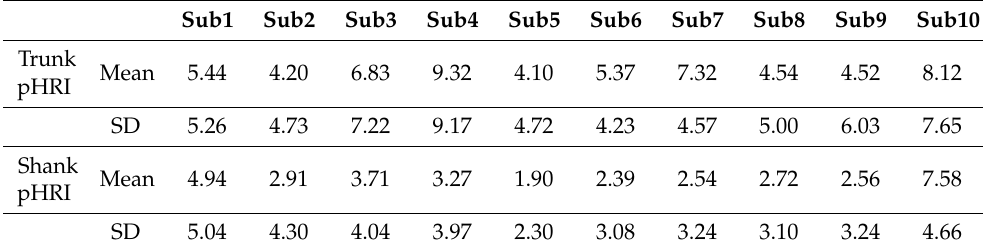
Table 12. Results of evaluation by shape deviation analysis (unit: mm).